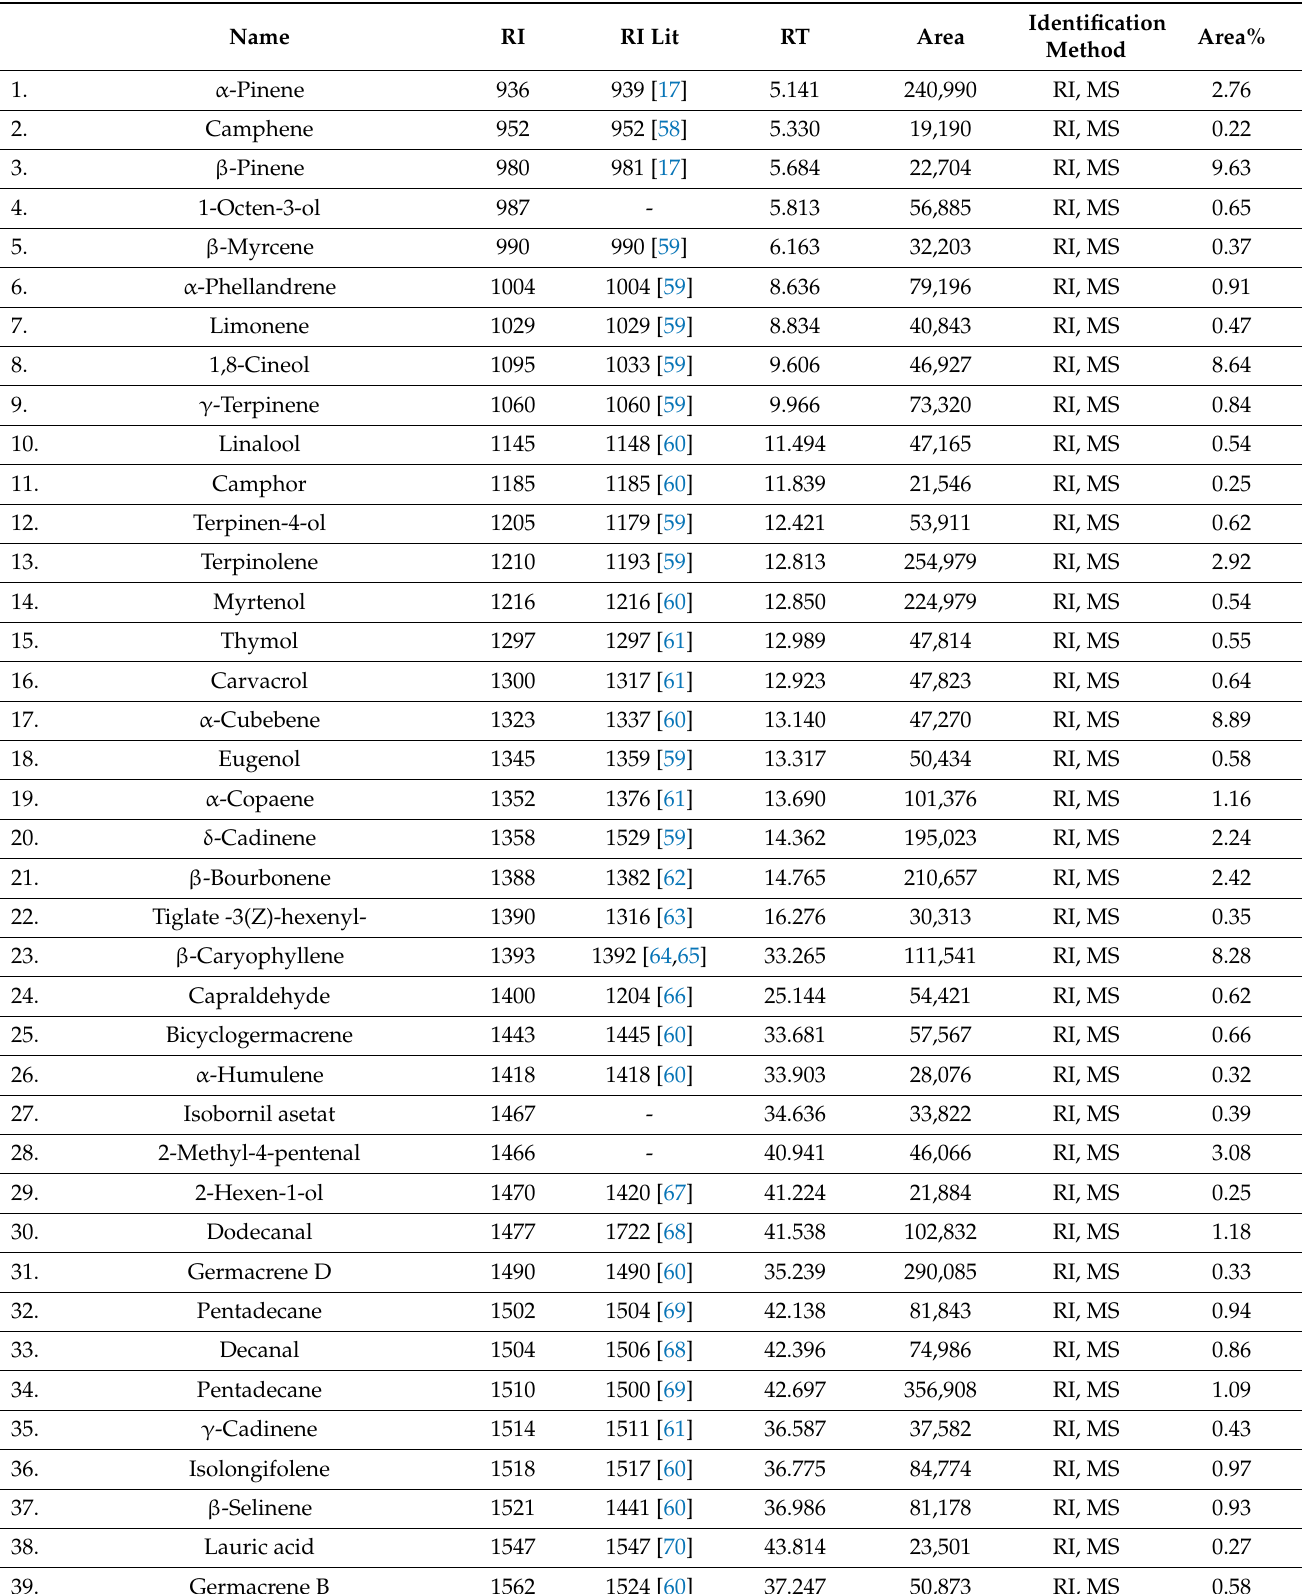
Table 5. Chemical composition of essential oil of P. bruguieri plants (sample collection described in Section